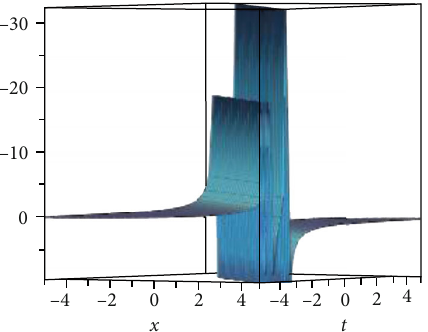
ð z Þ for the fi xed values v = 1 , z r ,1